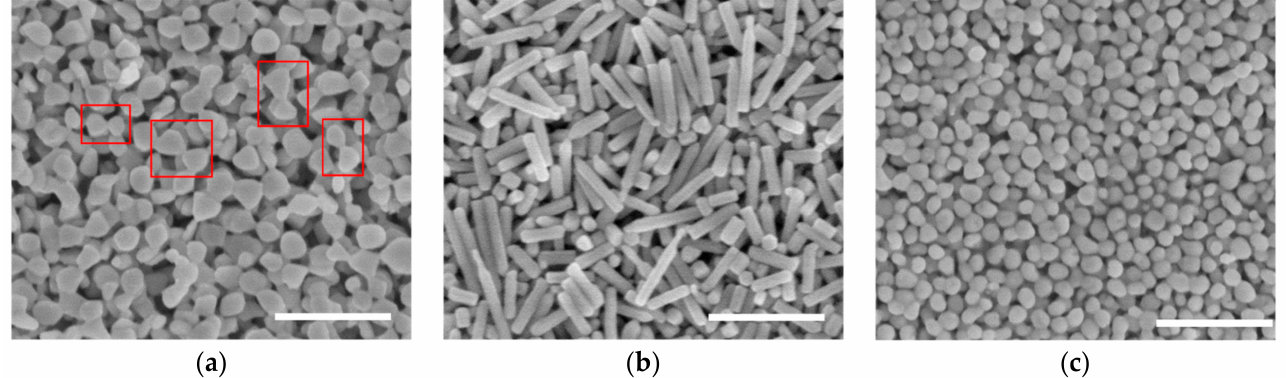
Figure 4. Images of the silver nanostructures prepared from 4 µ L of silver nanoparticle suspension after 1 h at ( a ) 0 ◦ C; ( b ) 27 ◦ C; and ( c ) 80 ◦ C. The scale bar is 500